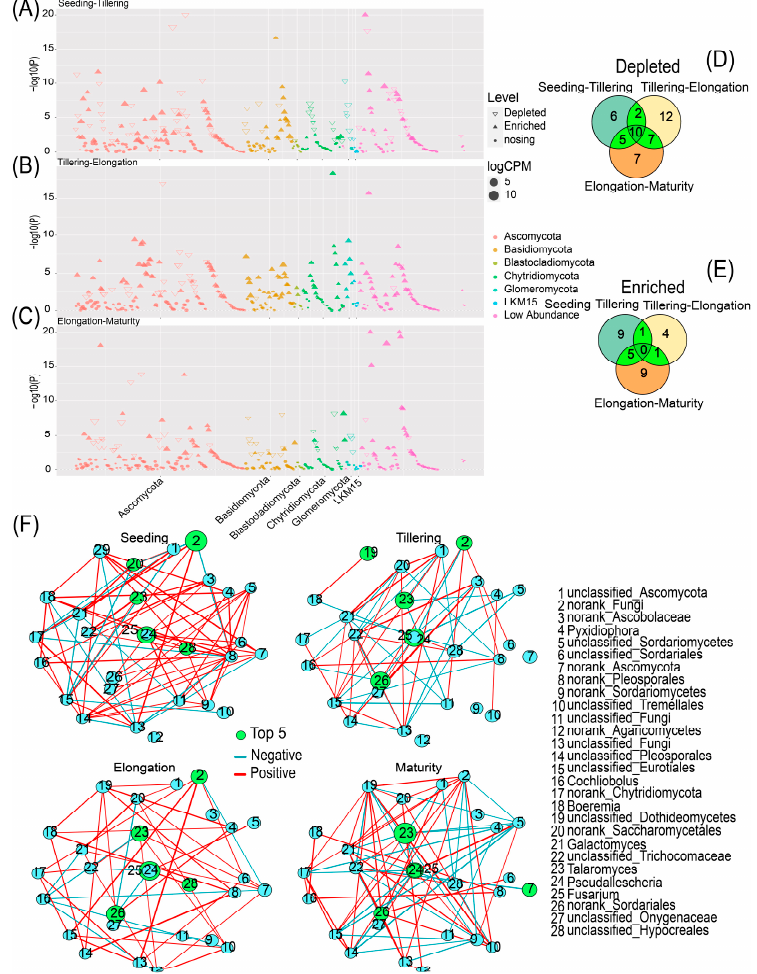
Figure 5. Taxonomic of differential fungi between the two periods of root microbiota. The Manhattan plot shows OTUs enriched or decreased in sugarcane in different stages. Each dot or triangle represents a single OTU. OTUs enriched or decreased in the sugarcane rhizosphere are represented by filled or empty triangles, respectively (FDR adjusted p < 0.05, Wilcoxon rank sum test). OTUs are arranged in taxonomic order and colored according to the phylum. ( A ) Seeding vs. Tillering; ( B ) Tillering vs. Elongation; ( C ) Elongation vs. Maturity. ( D ) Venn diagram of fungi decreasing between successive stages at the genus level. ( E ) Venn diagram of fungi enriched between successive stages at the genus level. ( F ) Co-occurrence network based on spearman correlation (Top 28 fungal genera, |r| > 0.4, p < 0.05), the size of the circles represents the relative abundance of the fungal genera and the thickness of the lines represents the size of the correlation.